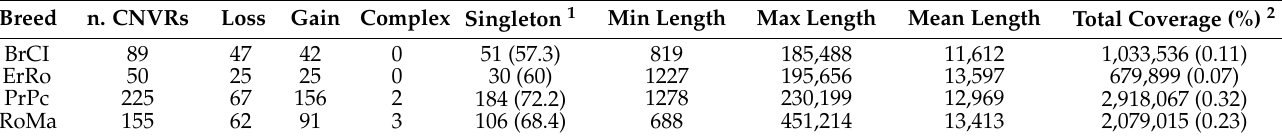
Table 3. Summary of CNVRs mapped in each turkey breed. All lengths are expressed in base pairs (bp). Breed n. CNVRs Loss Gain Complex